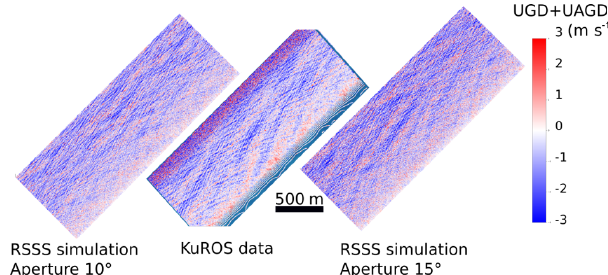
Figure 17. Qualitative validation of the R3S simulations of the radar imaging mechanism (Nouguier, 2019). Both the real data and simu- lation contain the geophysical modulation of velocities associated with surface velocities and slopes in the look direction (part of U GD ) as well as aircraft velocities and slopes in the flight direction (part of U AGD ). Note that the wave phases in the R3S simulation are random and cannot be expected to match those in the data or between the two